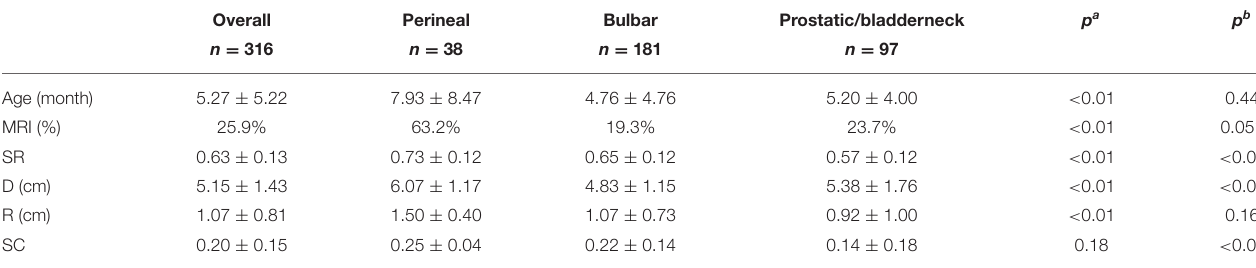
TABLE 1 | Demographic and clinical characteristics.